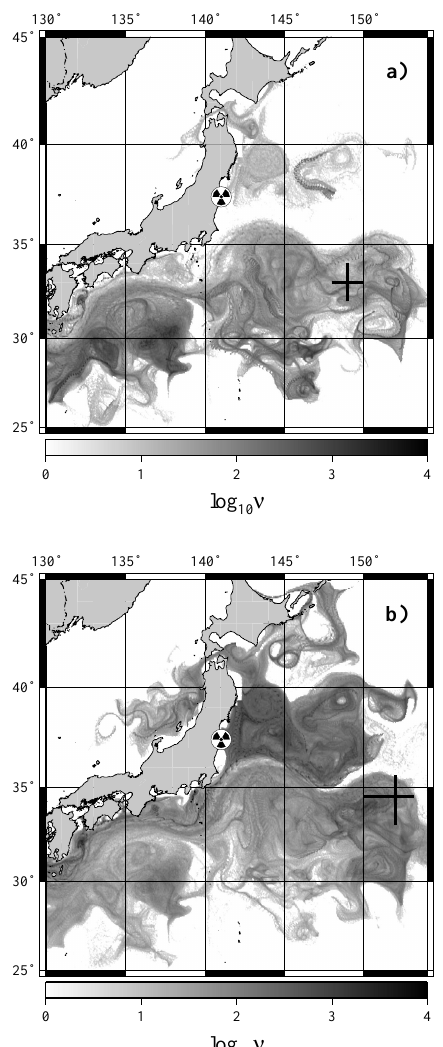
Fig. 4. Tracking maps for the markers placed on perpendicular ma- terial lines crossing (a) CR1 (Fig. 2c) and (b) CR2 (Fig. 2d). The maps show where the corresponding markers were walking after the Fukushima Nuclear Power Plant accident, from 11 March to 10 April 2011. The density of traces is in the logarithmic